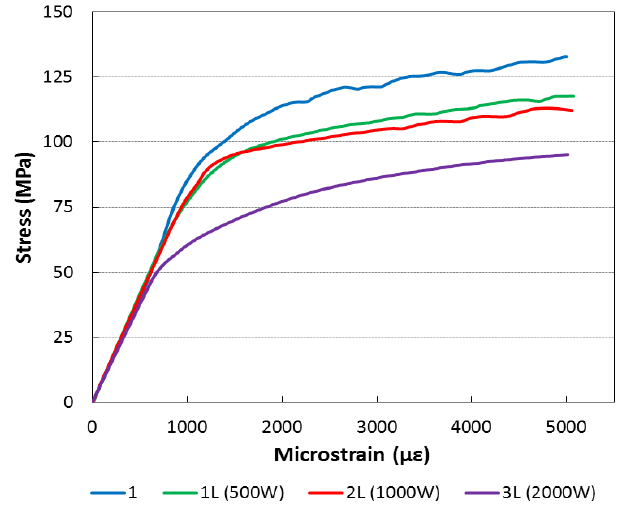
Figure 20. Complete tensile test.